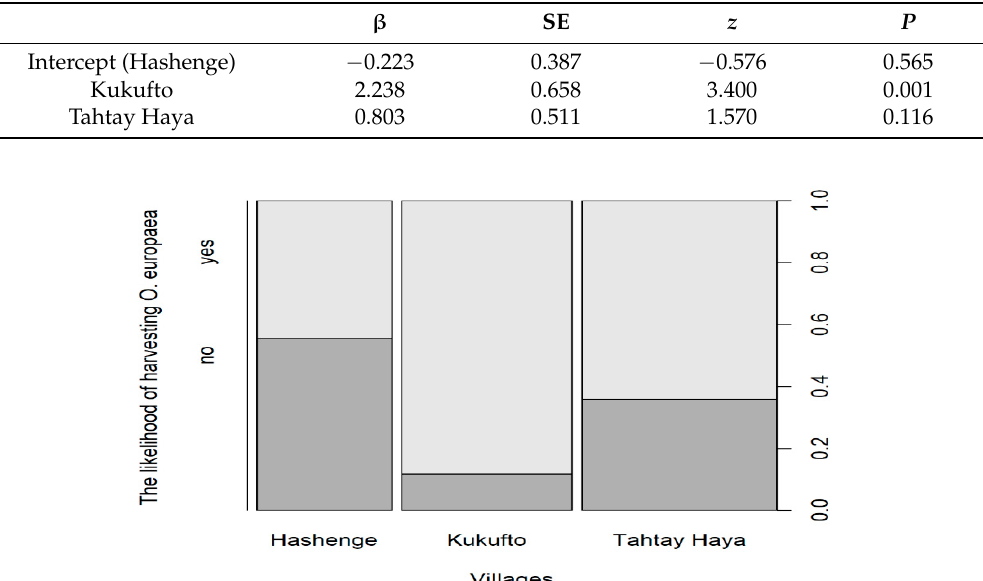
Table 6. The estimated likelihood O. europaea (Wall. ex G. Don) Cif. being harvested from Hugumburda Forest by people from different villages adjacent to the forest, based on results from a binary GLM (response: harvest versus non-harvest) with logit link function. GLM, General Linear Models. Also shown are the parameter estimates ( β ) and associated standard errors and z -values.